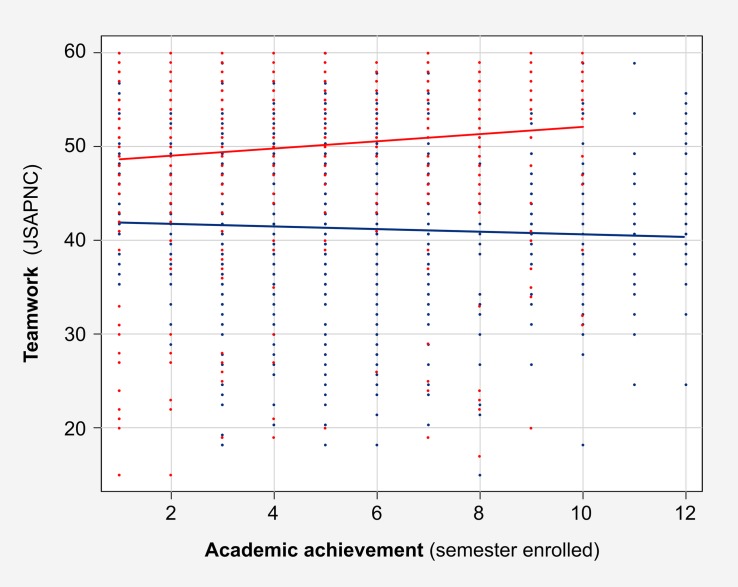
Global scores of the Jefferson Scale of Attitudes toward Physician–Nurse Collaboration (JSAPNC) in medicine students group (blue) and nursing students group (red) according to their academic achievement, measured by semester enrolled.